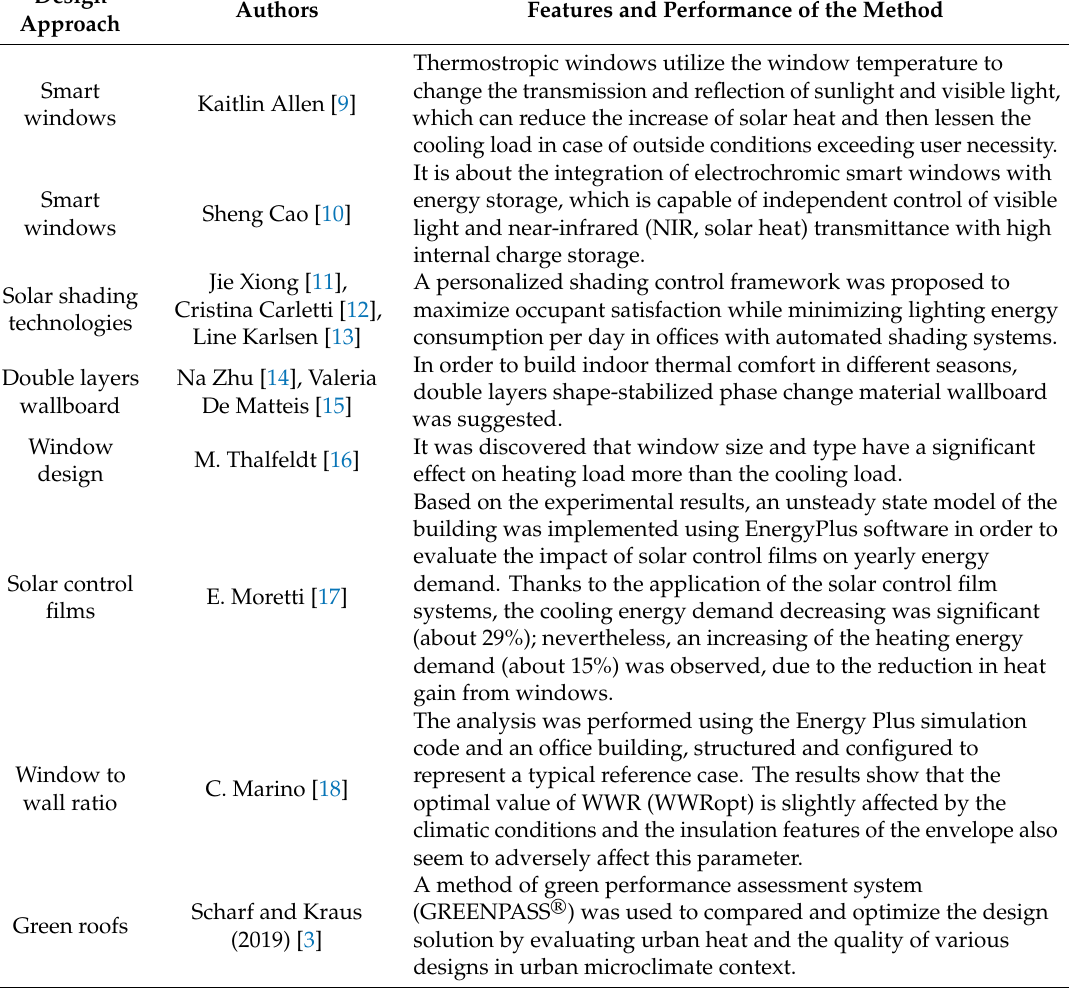
Table 1. Review of relevant researches about building cover